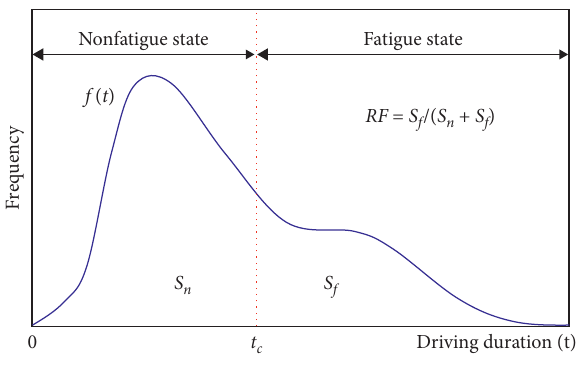
Figure 1: Concept of RF